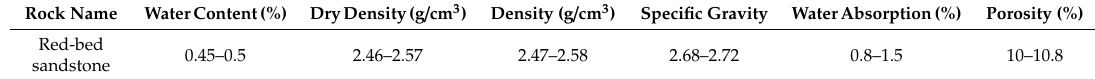
Figure 3. Sample chart: ( a ) Natural rock sample; ( b ) Saturated rock sample. Table 1. Red-bed sandstone physical property index